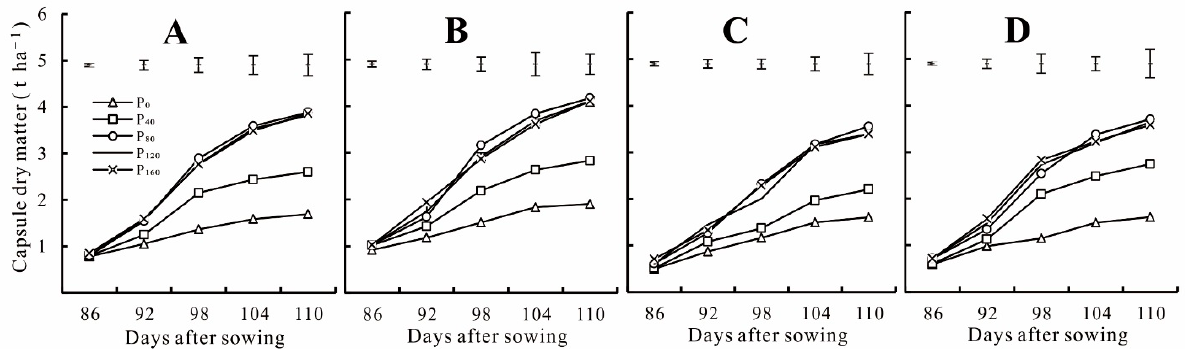
Figure 2. Changes in capsule dry matter for two flax cultivars at five P levels in two growing seasons. ( A ) Lonyaza 1 in 2018; ( B ) Longya 14 in 2018; ( C ) Lonyaza 1 in 2019 and ( D ) Longya 14 in 2019, respectively. The vertical bars indicate the least significant differences (LSDs) with p ≤ 0.05 among five P levels (n = 3).